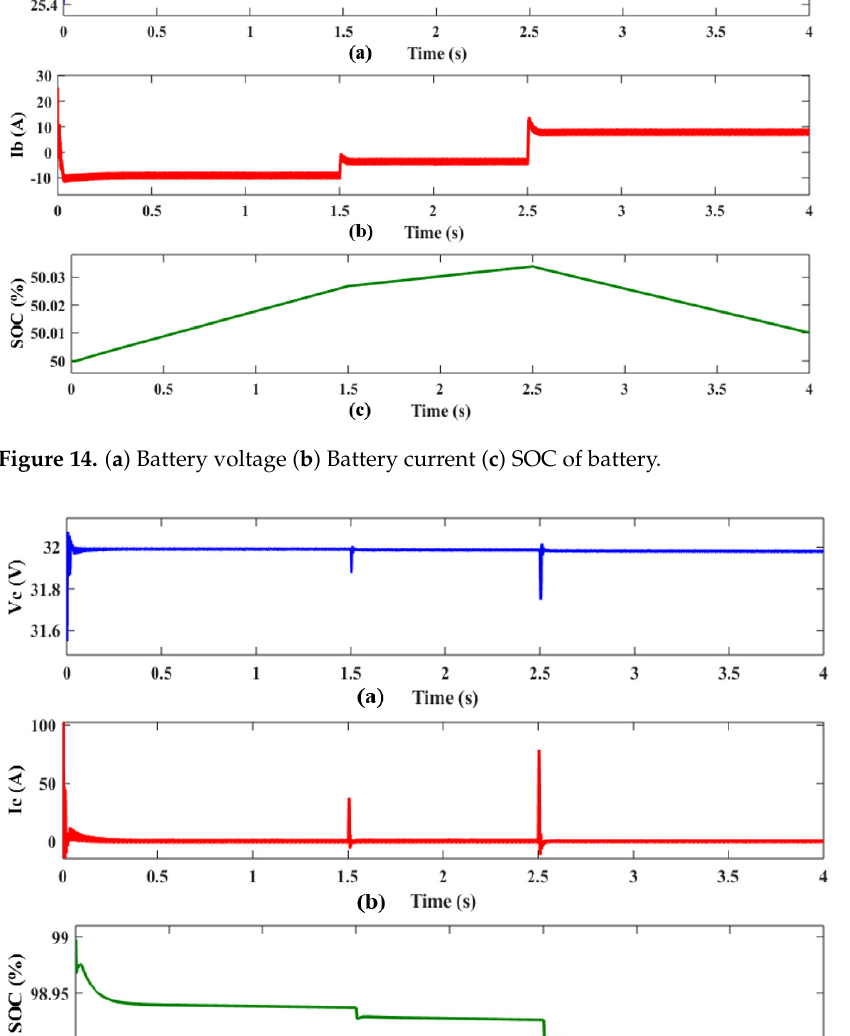
Figure 15. ( a ) Ultracapacitor voltage ( b ) Ultracapacitor current ( c ) SOC of ultracapacitor.